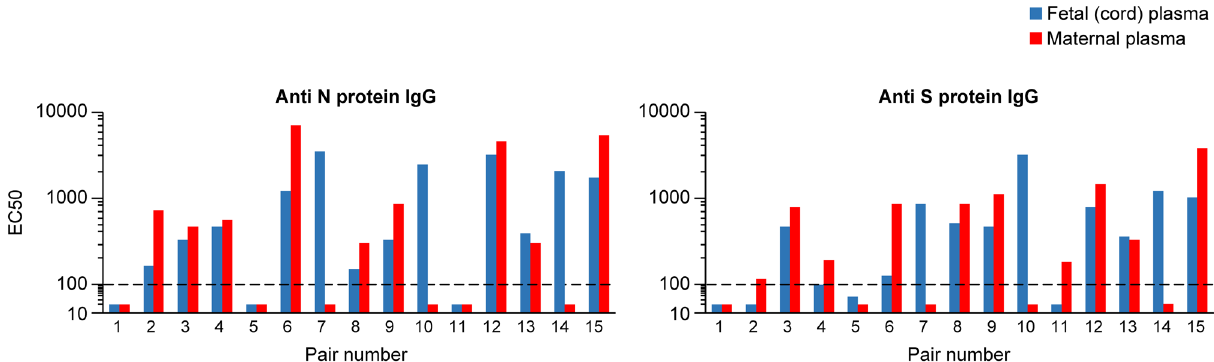
Figure 2. The level of IgG to the SARS-CoV2 N- or S-timer protein. Analysis was performed in 15 maternal– fetal paired plasma samples (x-axis), all with asymptomatic/mild disease. The y-axis denotes EC50 for each antibody, presented using a log10 scale. The level of detection was determined to be a 100-fold plasma dilution based upon previous studies. See text for